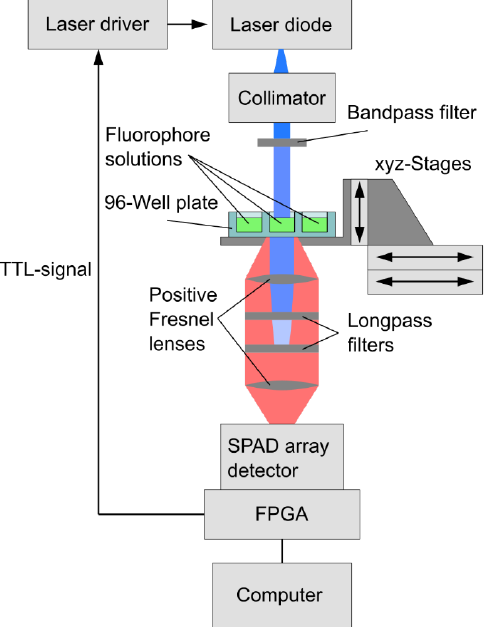
Figure 2. Schematic of the experimental FL setup. The fluorophore is excited by a collimated pulsed laser diode ( λ = 450 nm), filtered by a bandpass filter. The emitted fluorescence is collected and focused onto the SPAD array detector by two positive Fresnel lenses. Long-pass filters were used to filter out residual signal from the pulsed laser diode. A FPGA board was used to control trigger signals for laser and SPADs and to process the data from the SPAD array detector.